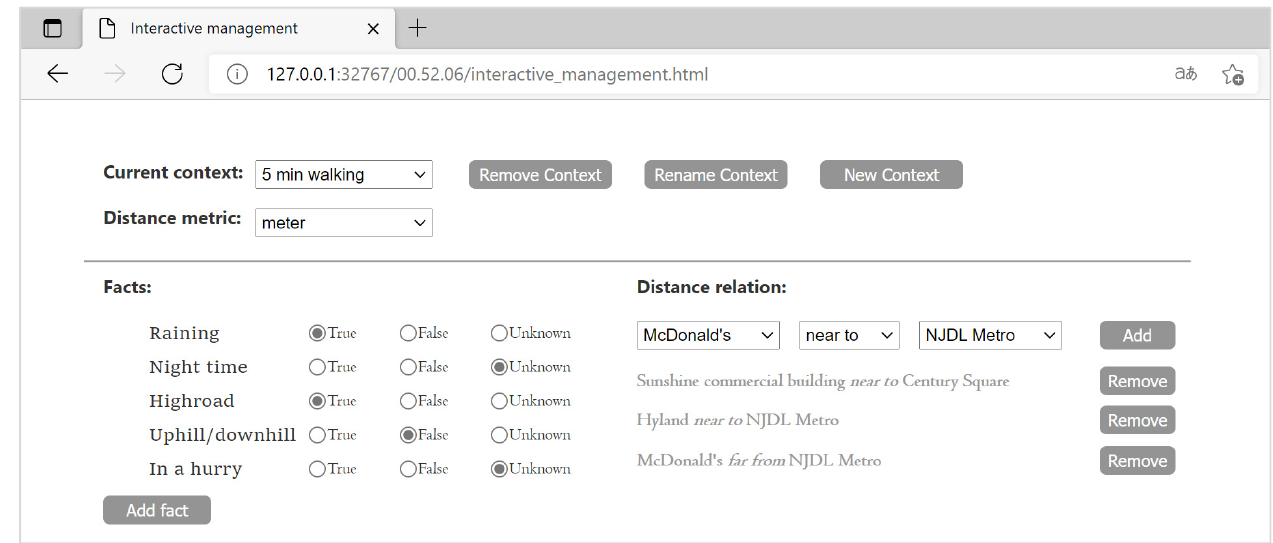
Figure 6. Interface diagram of back-stage management module in Q&A system.